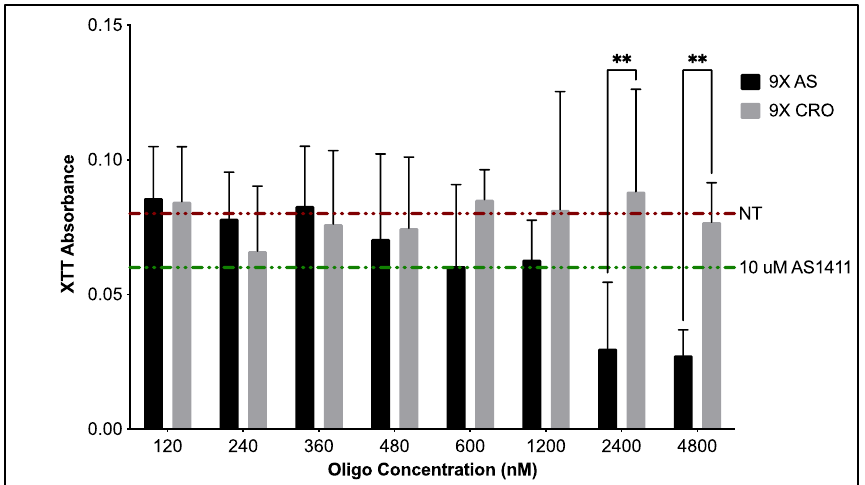
Figure 7. As measured by XTT assay, antiproliferative activity within U87MGs post-treatment with optimal 9X PEG-CRO control or PEG-AS1411 co-conjugated 4 nm GNPs. A significance level of ** represents p < 0.01.